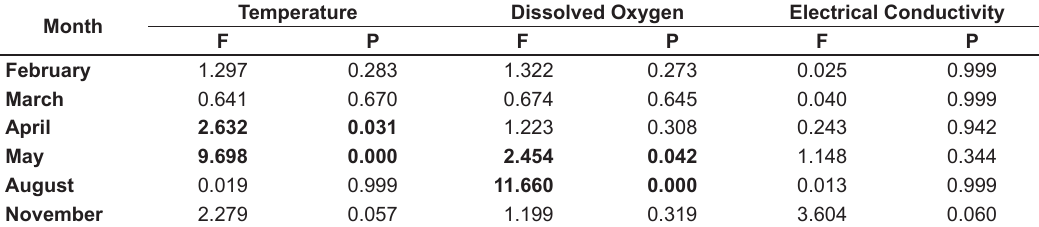
Figure 4. Daily variation in the vertical distribution of conductivity in Lago Catalão during the months of: Table 1. ANOVA results: analysis of the influence of time of day for a given month on the variance of temperature, dissolved oxygen and conductivity in Lago Catalão. Significant results (p< 0.05) indicated in